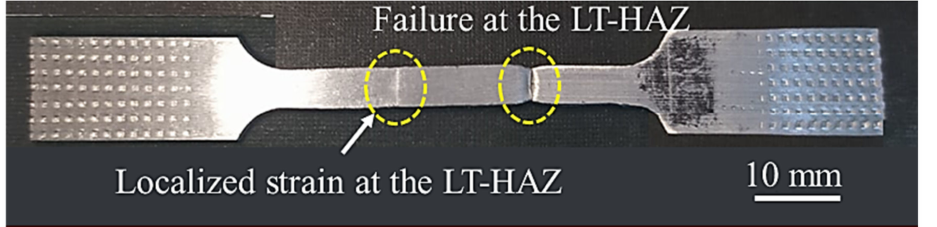
Figure 9. Dog-bone specimen of DP980 steel welded joint, failed at the soft region in the low temperature heat affected